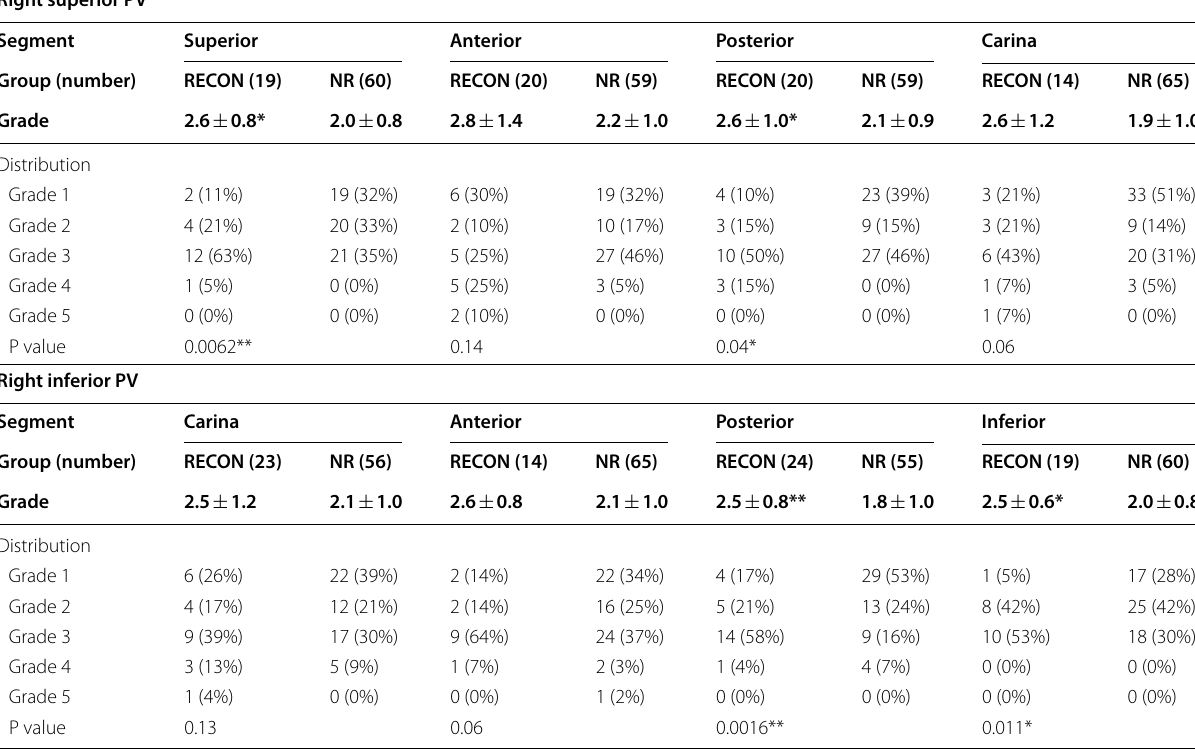
Table 5 Wall thickness of right PV